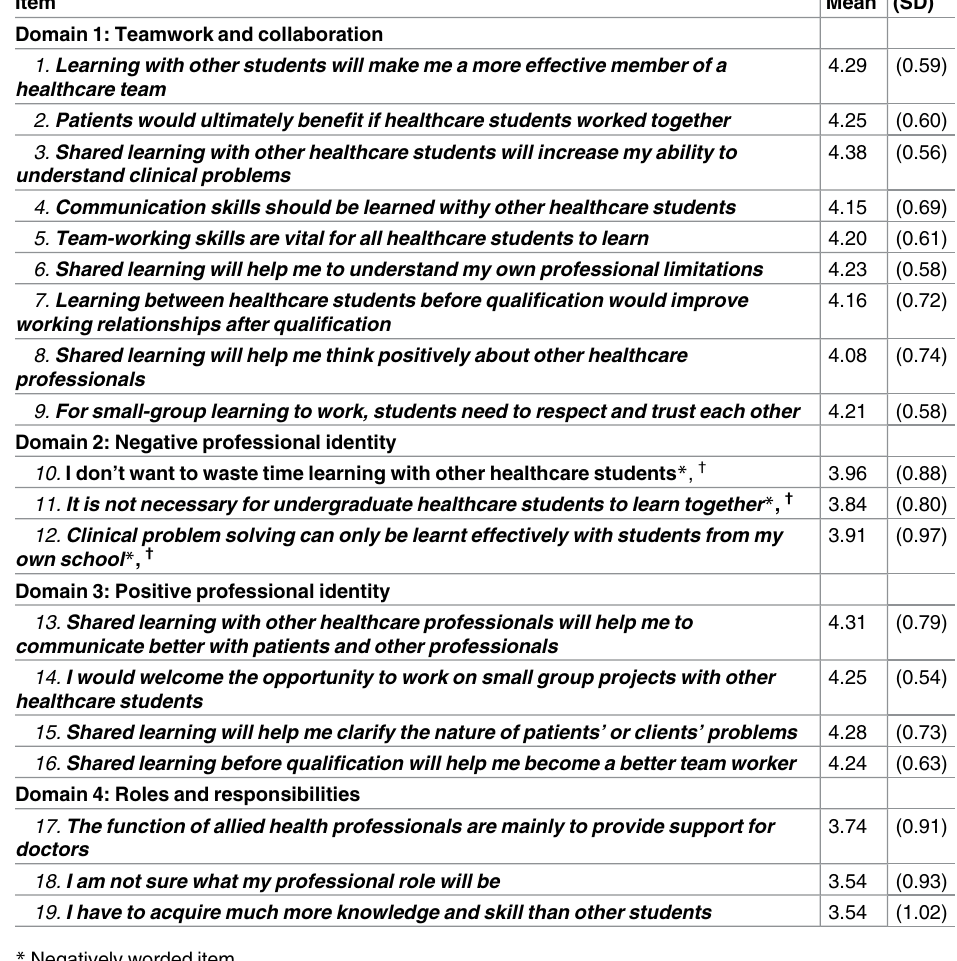
Table 2. Mean scores of each item of RIPLS (n =